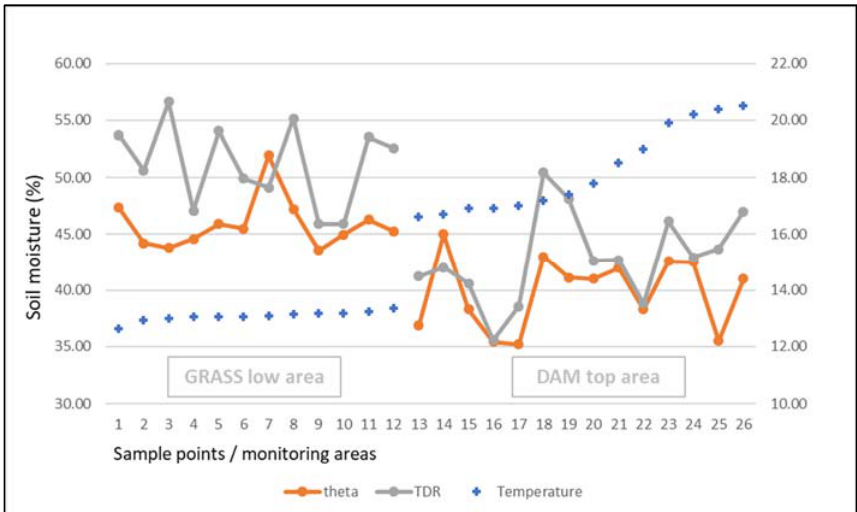
Figure 5. Comparison of soil moisture and